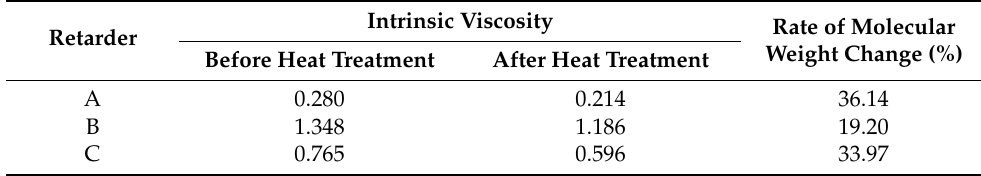
Table 5. Rate of change in molecular weight of